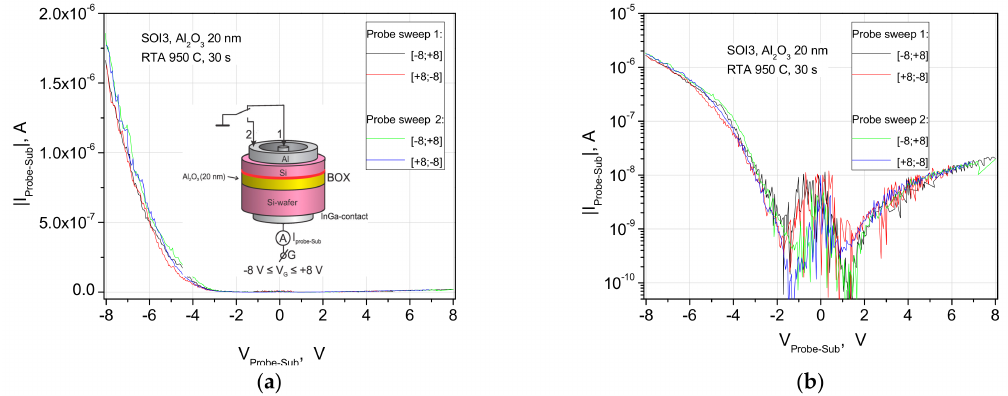
Figure 3. ( a ) Diode-like I-V characteristics of the source current-gate voltage (Probe sweep 2) and drain current-gate voltage (Probe sweep 1) contacts of n-SIS pseudo-MOSFETs on the structures 500 nm n-Si/20 nm Al 2 O 3 /Si-substrate after the RTA treatment at 950 ◦ C for 30 s. The I-V curves are shown for the sweep in the range V g = − 8 + 8 V on the linear scale; ( b ) the same on the semi-logarithmic scales.